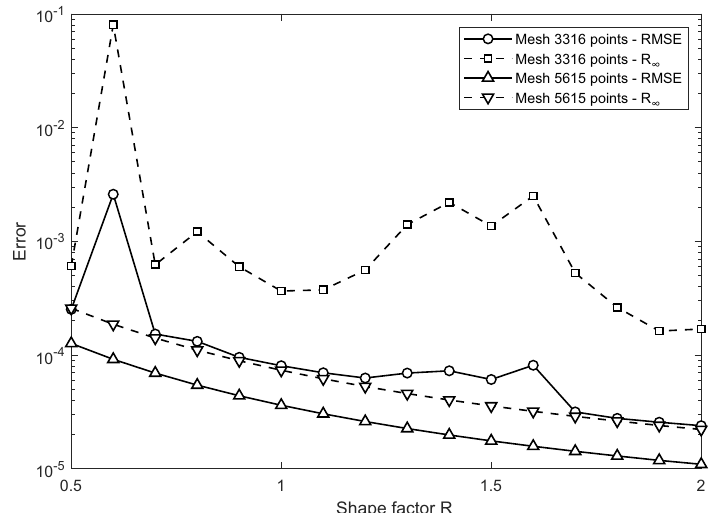
Figure 9. Example No. 2—RMSE and R ∞ as functions of the shape factor R